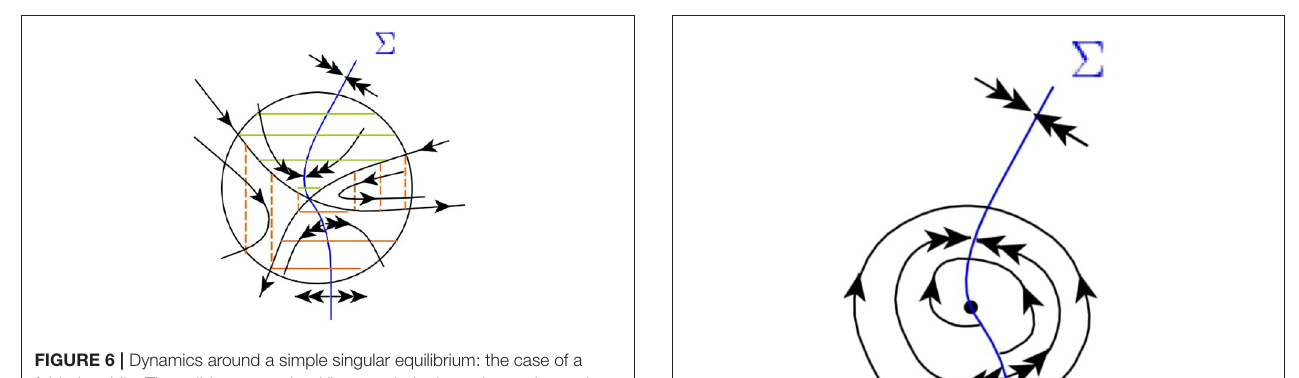
FIGURE 6 | Dynamics around a simple singular equilibrium: the case of a folded saddle. The solid green and red lines mark the incoming and outgoing sectors, respectively. The dashed red lines mark the unstable sector.